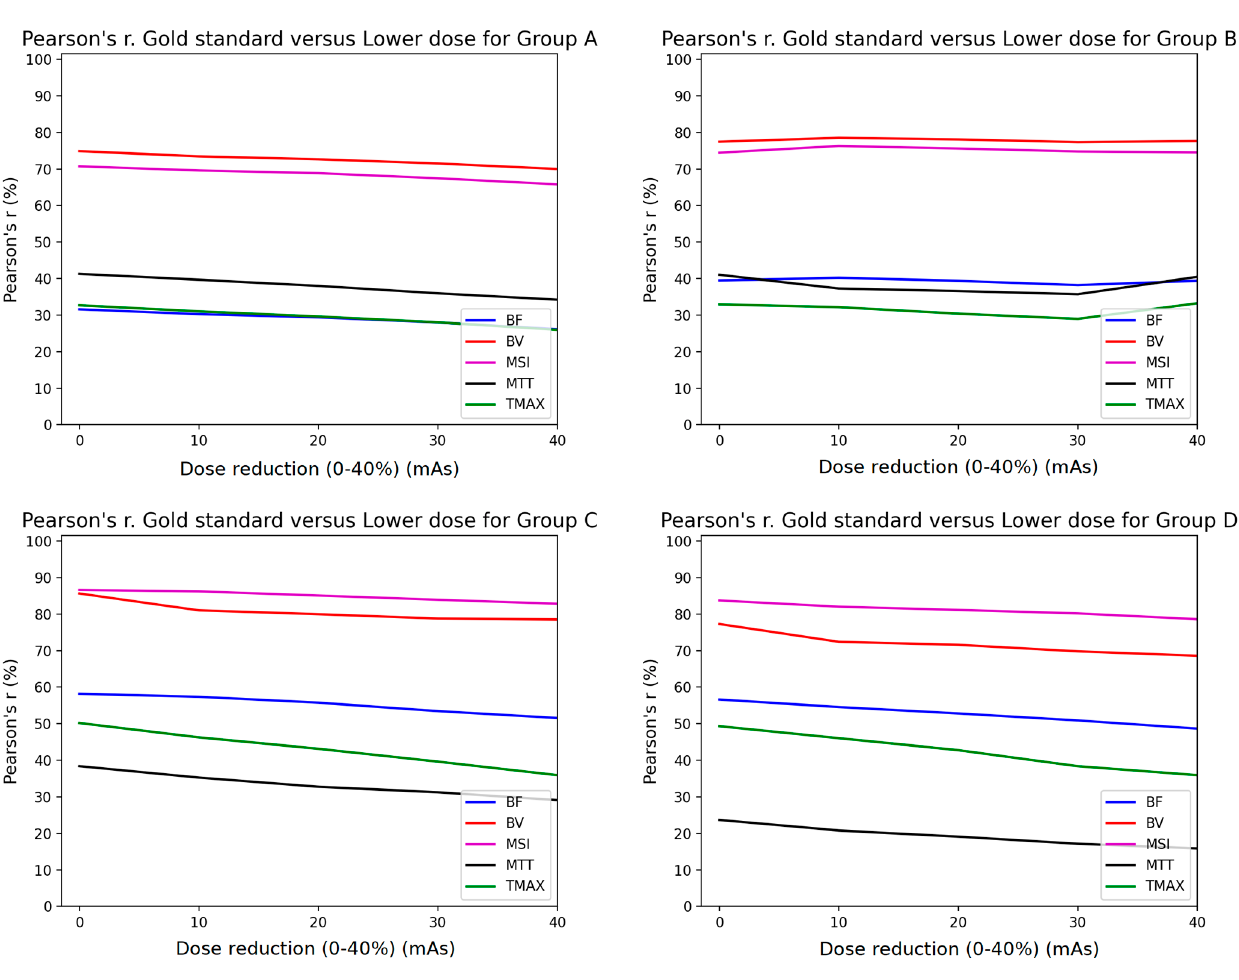
Figure 4. Comparison of Pearson’s correlation coefficient between GSmaps and the maps corresponding to lower mAs settings in combination with 1/2 temporal sampling for all study groups ( A – D ).